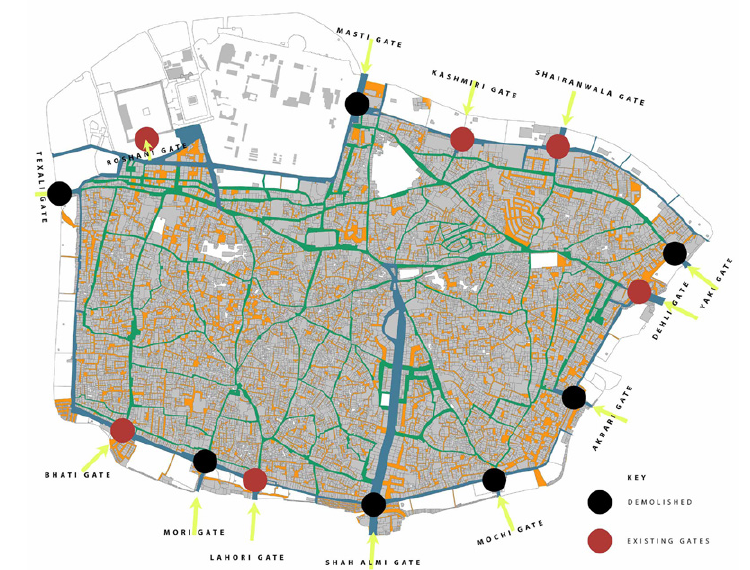
Figure 2 . Walled City of Lahore (source: Zahid, 2021)